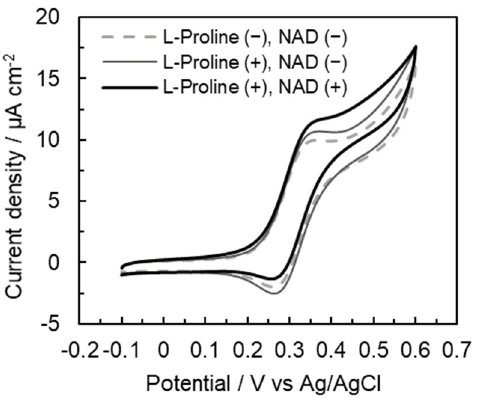
Figure 4. CV grams of the tetra-enzyme immobilized electrode using L -proline or L -glutamate as